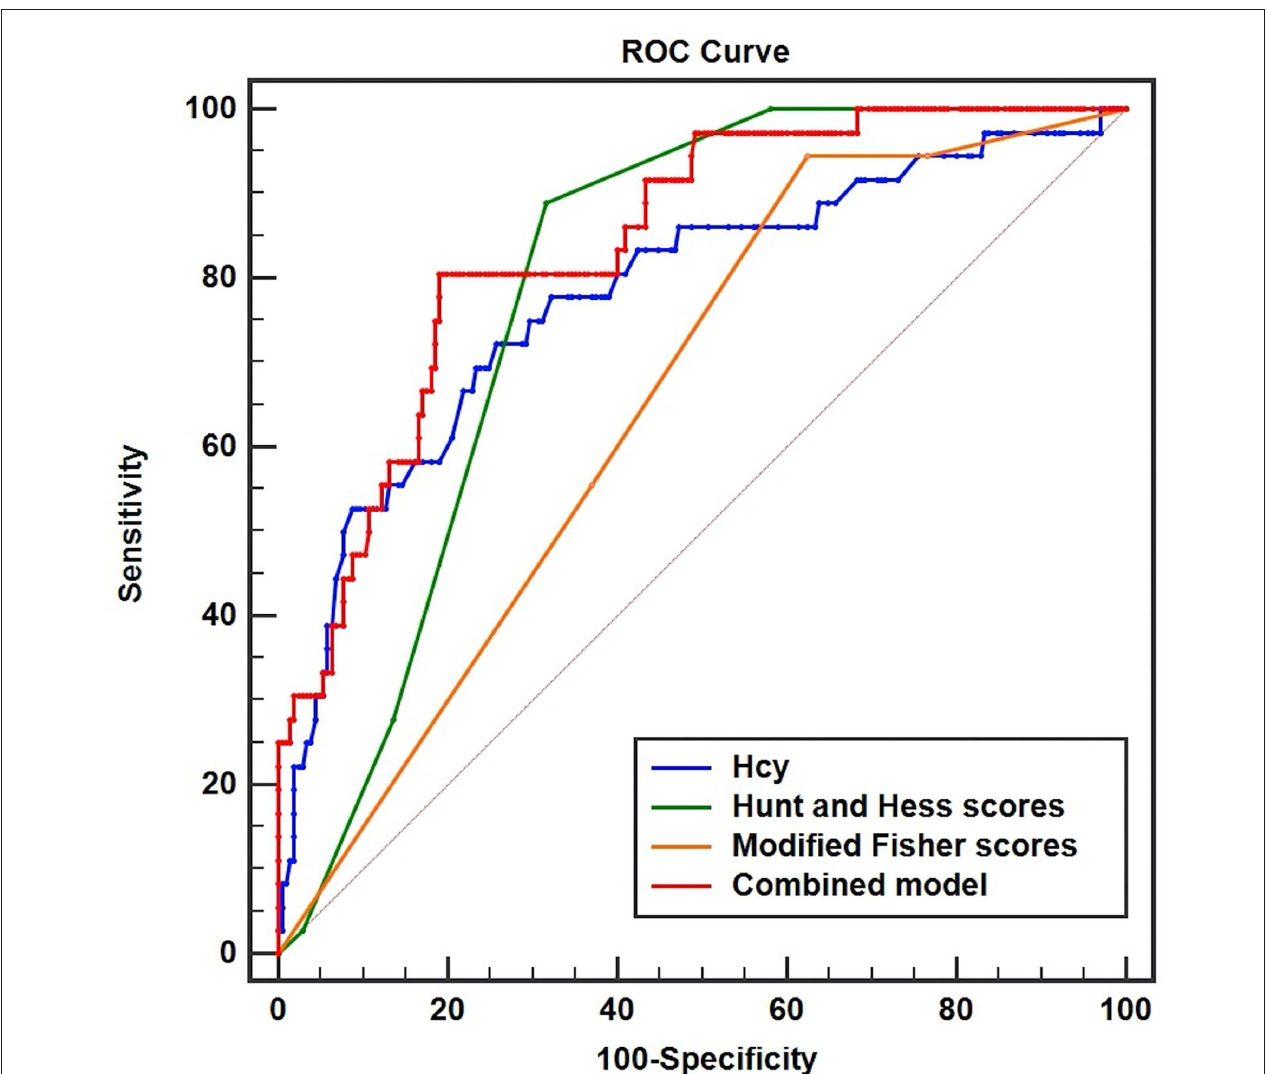
FIGURE 4 | Receiver operator characteristic curve analysis comparing serum homocysteine (Hcy) levels, Hunt and Hess scores, modified Fisher scores, and combined model (Hcy/Hunt and Hess scores/modified Fisher scores) on predicting DCI in patients with aSAH. The area under the curves of serum Hcy levels, Hunt and Hess scores, modified Fisher scores, and combined model were 0.781 (95%CI, 0.723–0.831, P < 0.001), 0.790 (95%CI, 0.733–0.840, P < 0.001), 0.654 (95%CI, 0.591–0.714, P < 0.001), and 0.842 (95%CI, 0.789–0.885, P < 0.001),